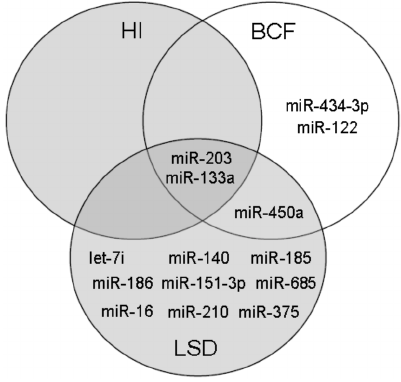
Figure 3. Venn diagram. Numbers of altered miRNAs at hyperinsulinemia (HI), β cell failure (BCF) and late-stage diabetes (LSD) are summarized. Overlaps represent those miRNAs that are significantly changed at more than one time point.